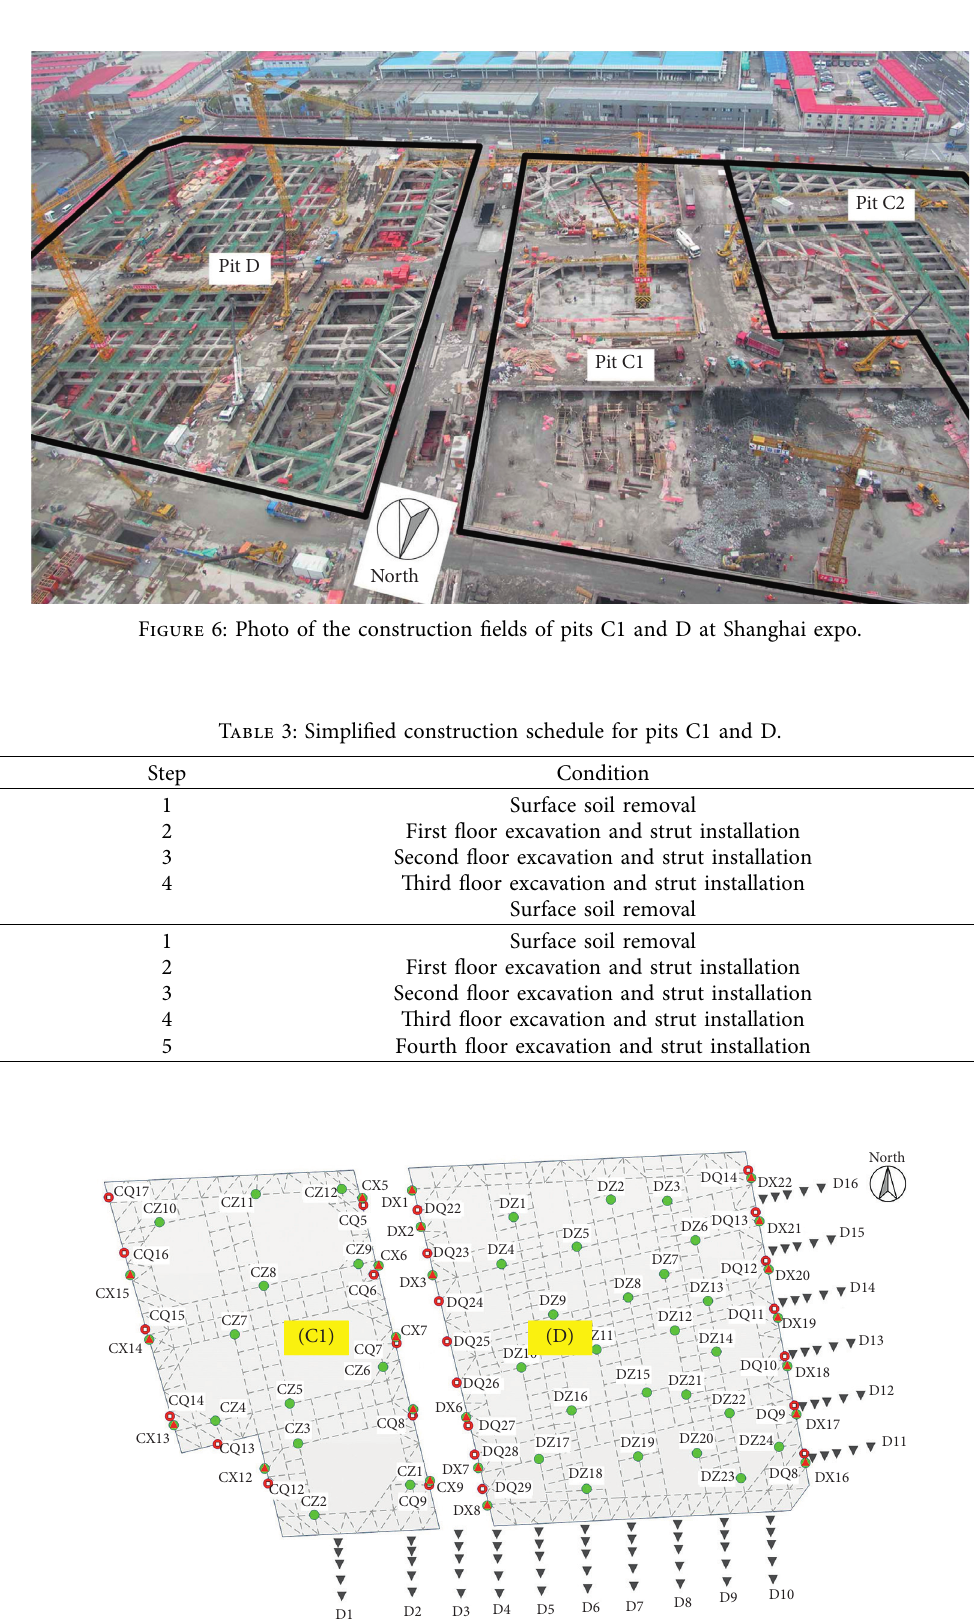
Figure 7: Layout of measured points and corresponding distance.